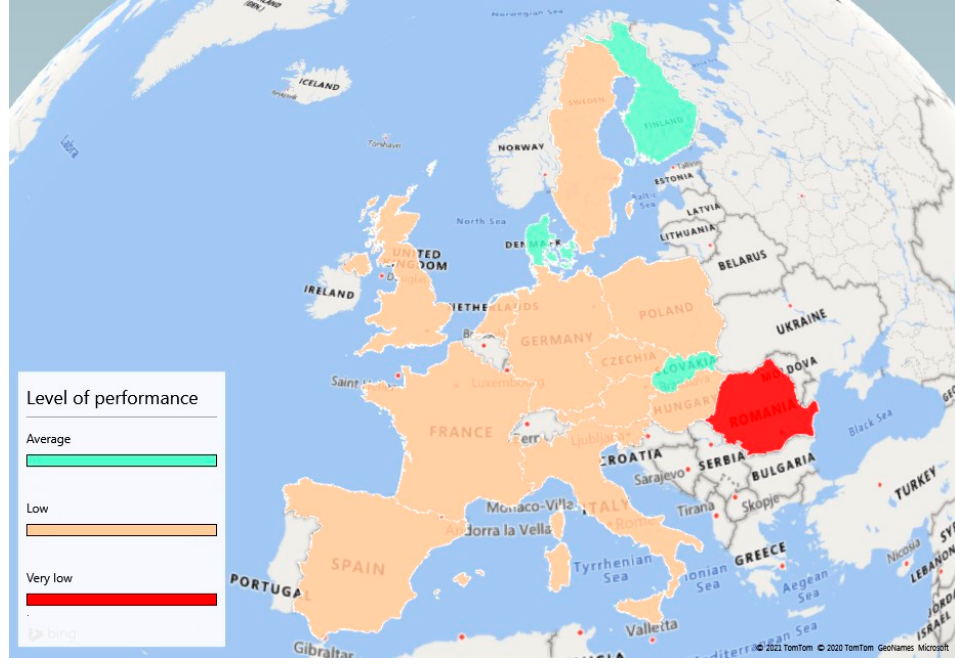
Figure 5. Level of performance in the bioenergy field. Source: authors.